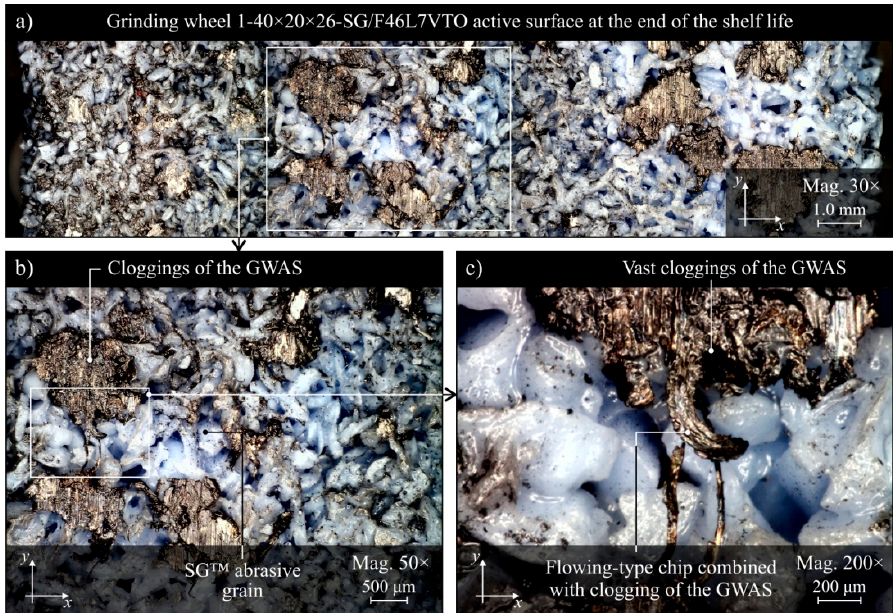
Figure 14. Microscope images of the grinding wheel active surface after machining using centrifugal MQL method of cooling and lubrication, recorded with the Dino-Lite Edge AM6715MZT digital measuring microscope: ( a ) magnification 30×; ( b ) magnification 50×; ( c ) magnification 200×.